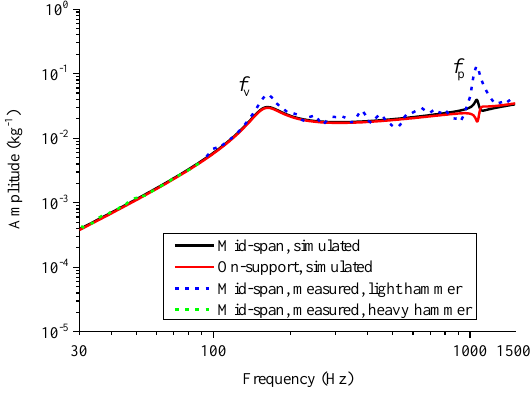
Figure 10. Amplitude of direct vertical rail accelerance.